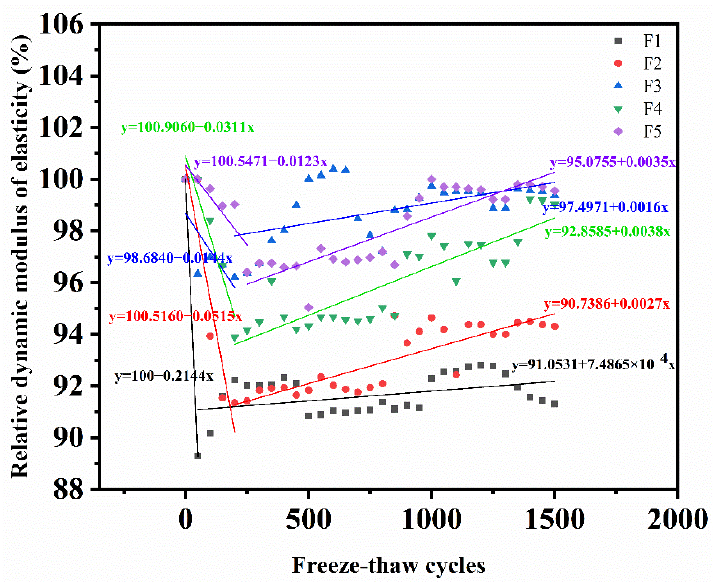
Figure 7. RDME of MWCNTs UHPC during salt freezing cycles (F1: Composite salt and FT coupling; F2: Bicarbonate and FT coupling F3: Chloride salt and FT coupling; F4: Sulphate and FT coupling; F5: Clean water and FT coupling).